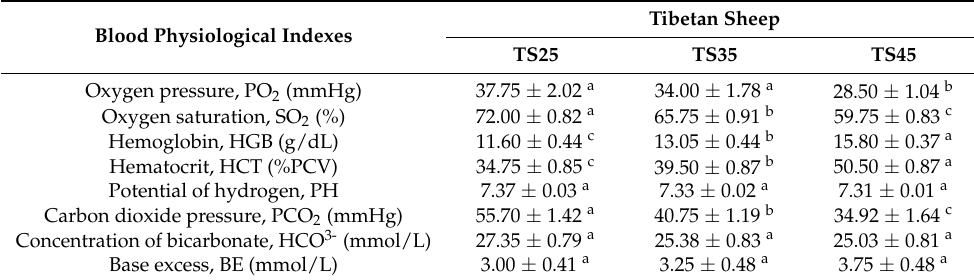
Table 2. Blood physiological indexes of Tibetan sheep at different altitudes.